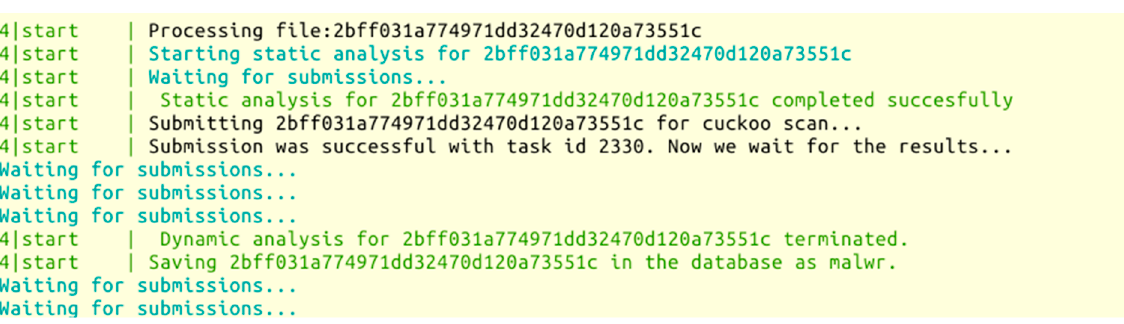
Figure 4. Real time information we collect from each sample.